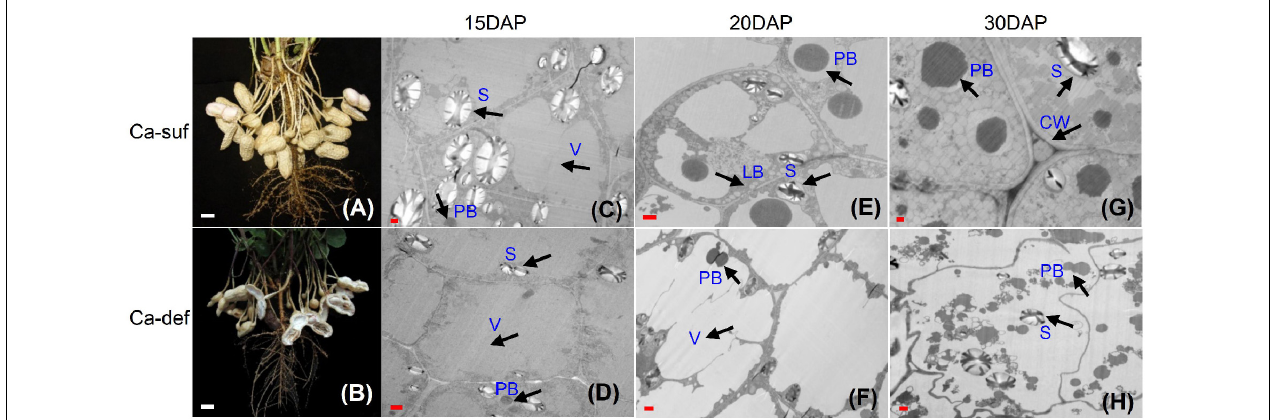
FIGURE 1 | Effects of calcium on peanut pod development and embryo cell characteristics. (A) Peanut pods grown under calcium sufficiency conditions at 30 DAP. (B) Peanut pods grown under calcium deficiency conditions at 30 DAP. (C) Embryo cell of 15 DAP with calcium sufficiency. (D) Embryo cell of 15 DAP with calcium deficiency. (E) Embryo cell of 20 DAP with calcium sufficiency. (F) Embryo cell of 20 DAP with calcium deficiency. (G) Embryo cell of 30 DAP with calcium sufficiency; (H) Embryo cell of 30 DAP with calcium deficiency. LB, lipid body; PB, protein body; N, nucleus; S, starch; V, vacuole; CW, cell wall. Bars indicated in panels (A,B) are 10 mm; Bars in panels (C,D) are 1 µ m and Bars in panels (E,F) are 0.1 µ